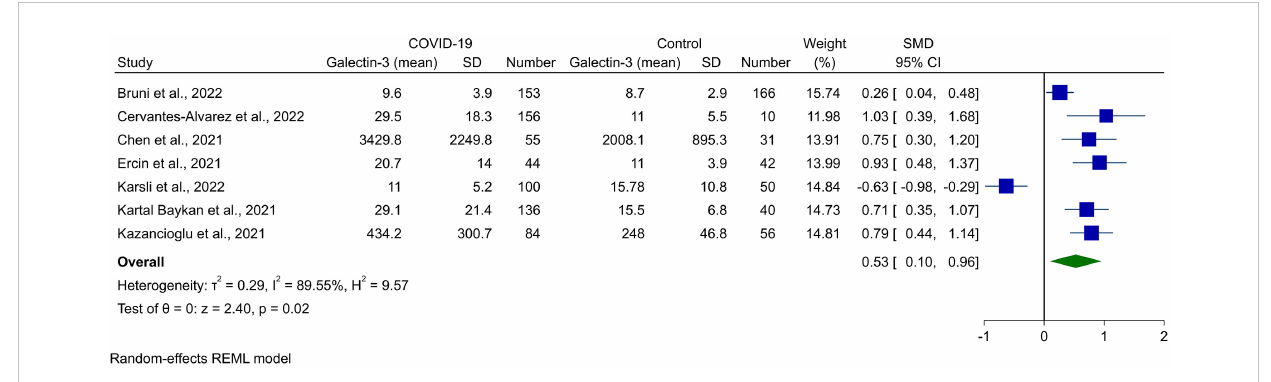
FIGURE 2 Forest plot for the meta-analysis of Gal-3 levels in COVID-19 patients vs. healthy